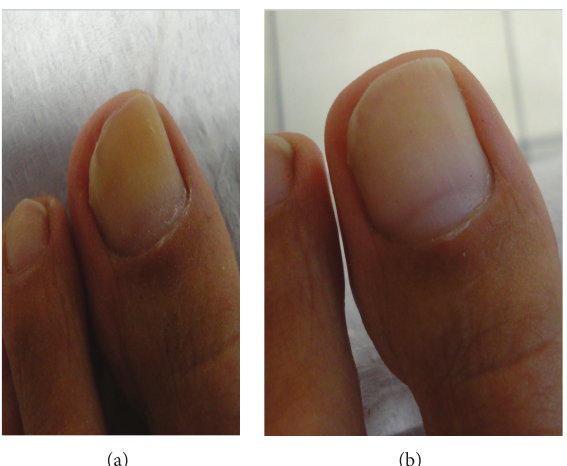
Figure 4: (a) 28-year-old female patient before treatment. Trichophyton rubrum was isolated on mycological testing. OSI was 12. (b) After treatment with great improvement. OSI is 1, showing 91.67% improvement.